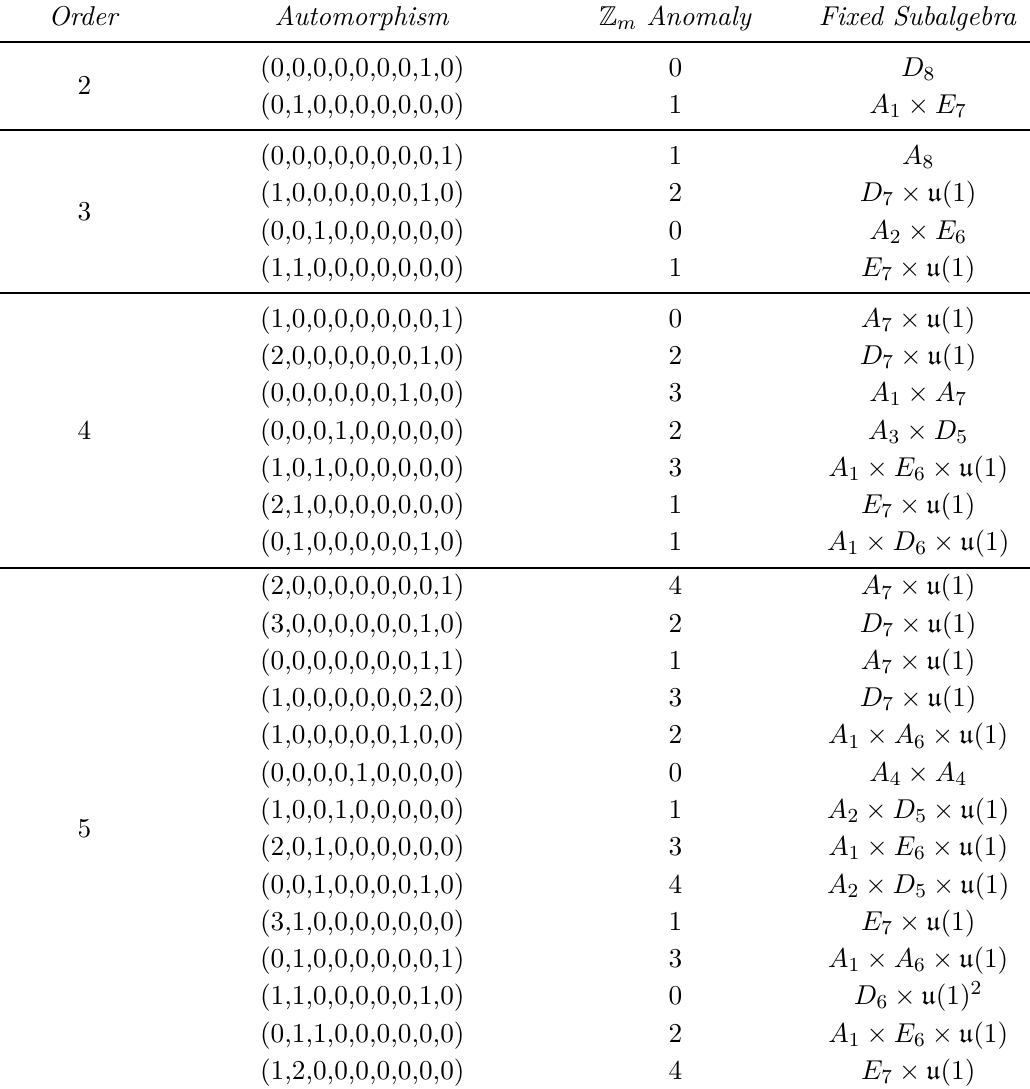
Table 2 . The finite order automorphisms of the E 8 Lie algebra can be enumerated, up to conjugacy, by Theorem 1. The automorphism is given by a sequence s which describes the automorphism. In physics terms, s describes how the operators of V E are screened and the anomaly of that 8